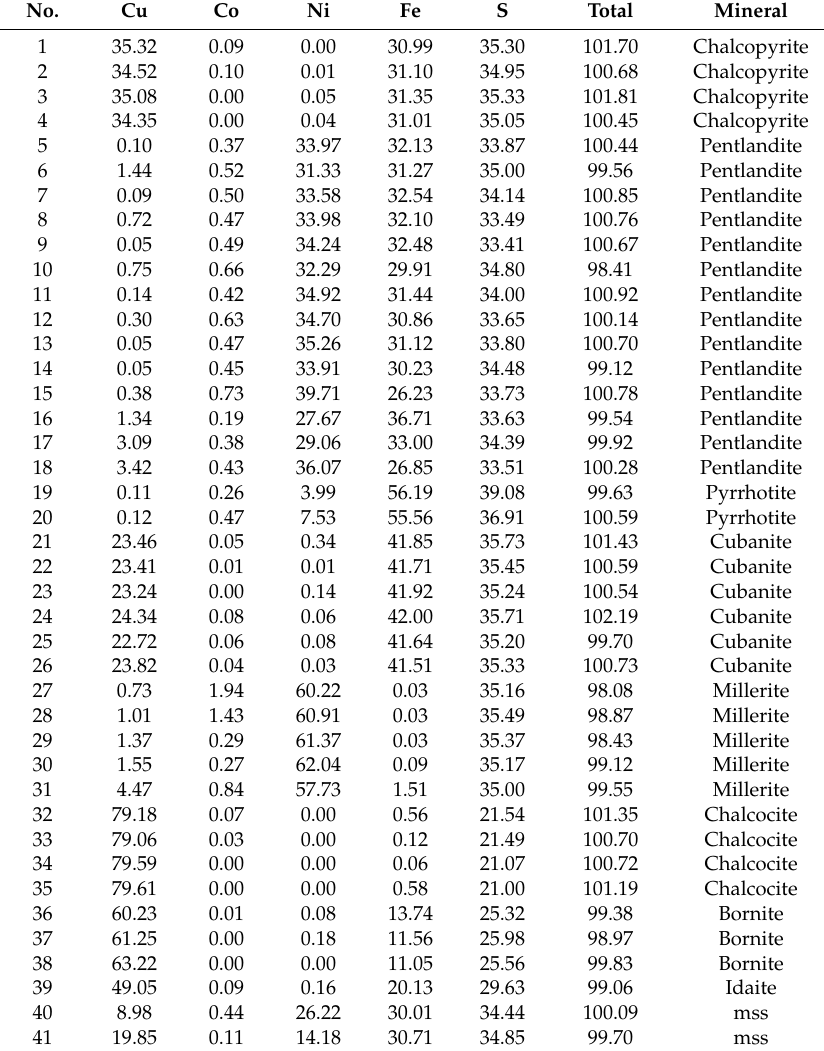
Table 5. Composition of ore minerals from the Southern 2 orebody, wt